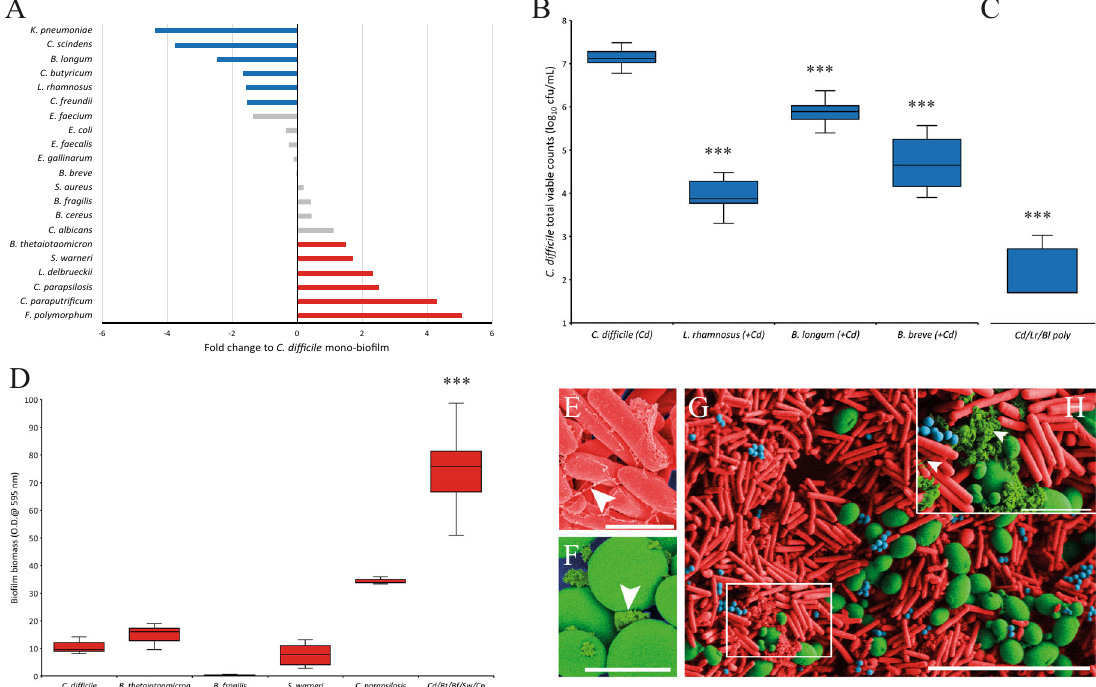
Fig. 4 Bio fi lm-associated microbiota can affect C. dif fi cile bio fi lm formation. A Bio fi lm formation of C. dif fi cile when co-cultured with different microbial species, compared with the bio fi lm formed from a C. dif fi cile monoculture. Blue or red bars indicate species that signi fi cantly ( p ≤ 0.05) reduced or increased the bio fi lm formed and grey bars represent species that did not signi fi cantly affect bio fi lm formation. Results expressed as fold change of crystal violet absorption of the dual co-culture vs monoculture. B Antagonistic bacteria reduced C. dif fi cile recoveries from bio fi lms. C. dif fi cile recoveries from mono and dual culture bio fi lms and C the enhanced antagonistic effect of polymicrobial bio fi lms on C. dif fi cile recoveries from bio fi lms. D Poly synergistic bio fi lms are greater than the sum of the individual monoculture bio fi lms. B – D Results expressed as box and whisker plots showing the median log 10 cfu/mL, lower and upper quartile ranges, and the minimum and maximum results from at least four technical replicates from three biological repeats. False-coloured SEM of C. dif fi cile ( E , ×10,000, scale bar is 2 µm) and C. parapsilosis ( F , ×5000, scale bar 5 µm) monoculture bio fi lms. Polymicrobial bio fi lms of C. dif fi cile (red cells), S. warneri (blue cells) and C. parapsilosis (green cells) showing close interaction between the microbial cells ( G , ×2500, scale bar 20 µm).